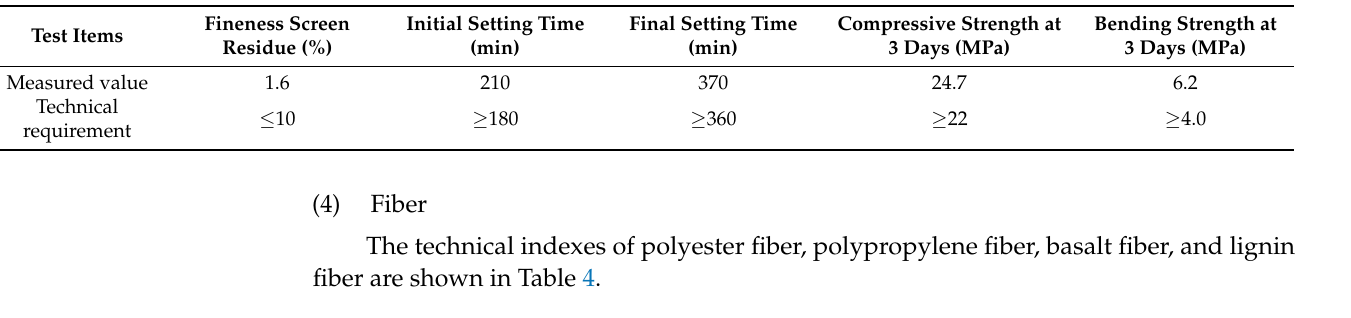
Table 4. Technical properties of different fiber